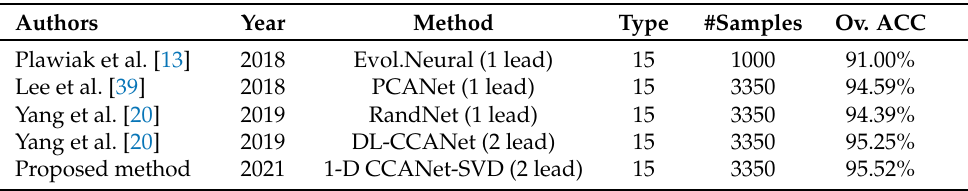
Table 7. Results for various methods on the MIT-BIH database.